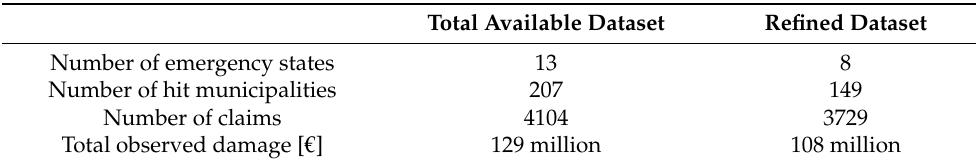
Table 2. Description of the available dataset for southern Italy: the total dataset has been cleaned of outliers and then claims aggregated into municipalities have been split between calibration and validation